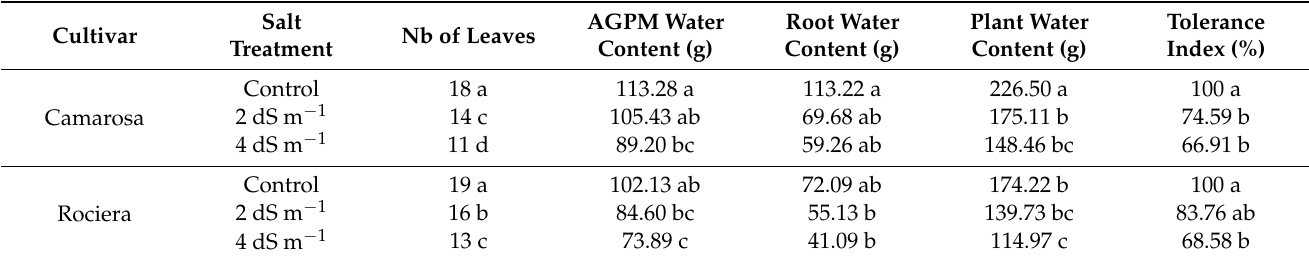
Table 10. Effect of salt stress on strawberry number of leaves, above-ground plant mass (AGPM) water content, root water content, plant water content and plant tolerance index